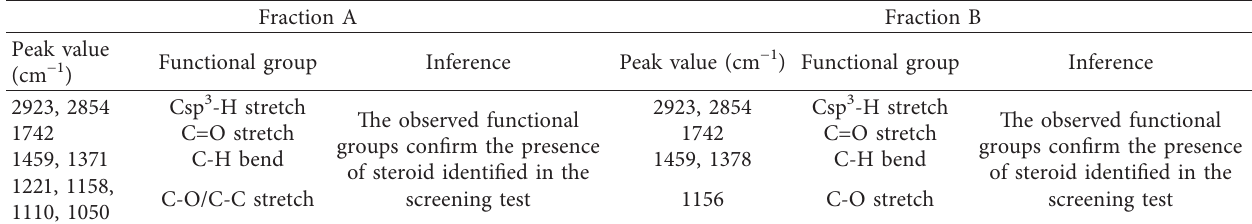
Table 11: FTIR interpretation of purified fractions A and B from the methanol extract of V. camporum. Fraction A Fraction B